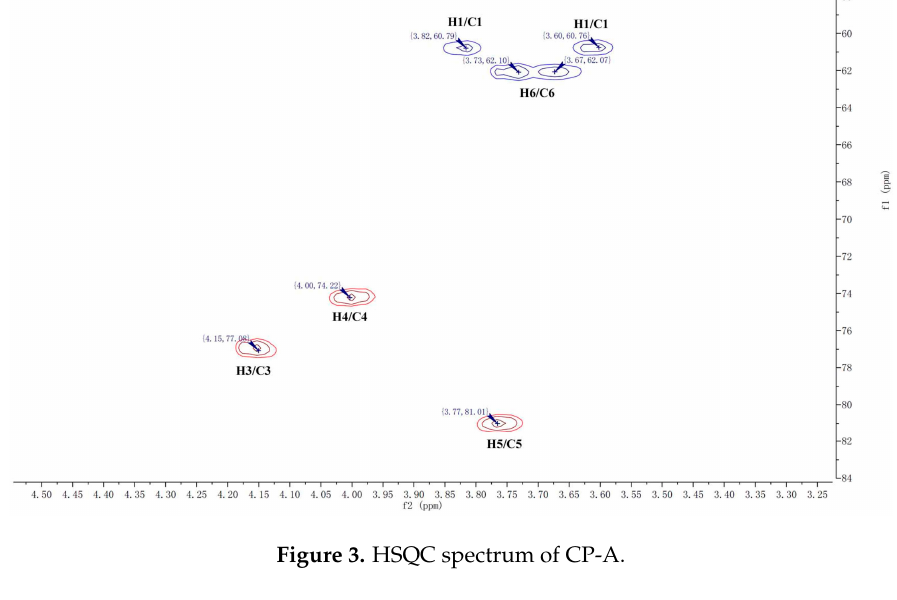
Figure 3 . HSQC spectrum of CP-A.